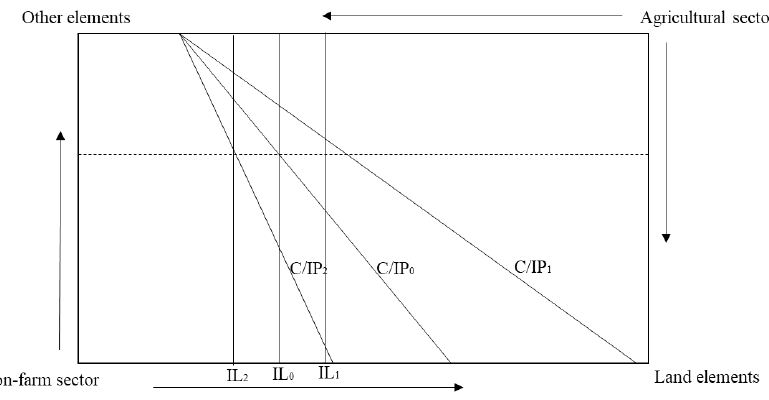
Figure 2. Schematic diagram of land supply change.